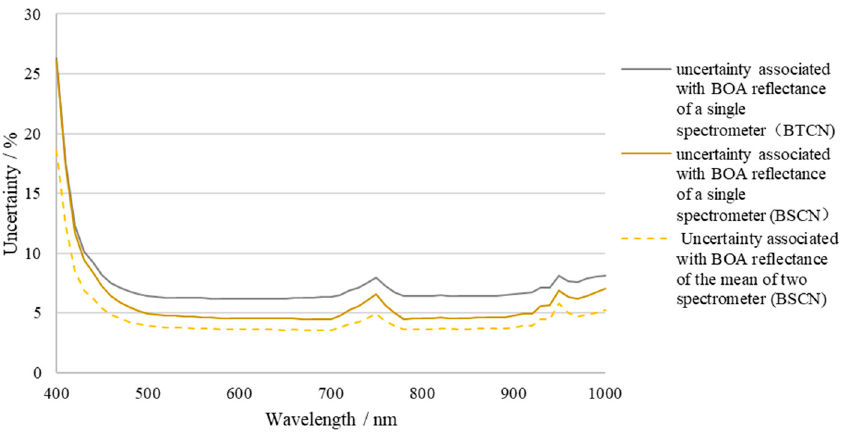
Figure 14. Uncertainty associated with the BOA reflectance.